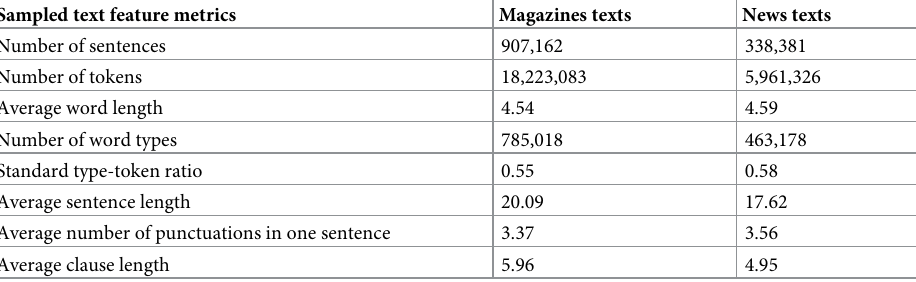
Table 2. Randomly sampled text feature